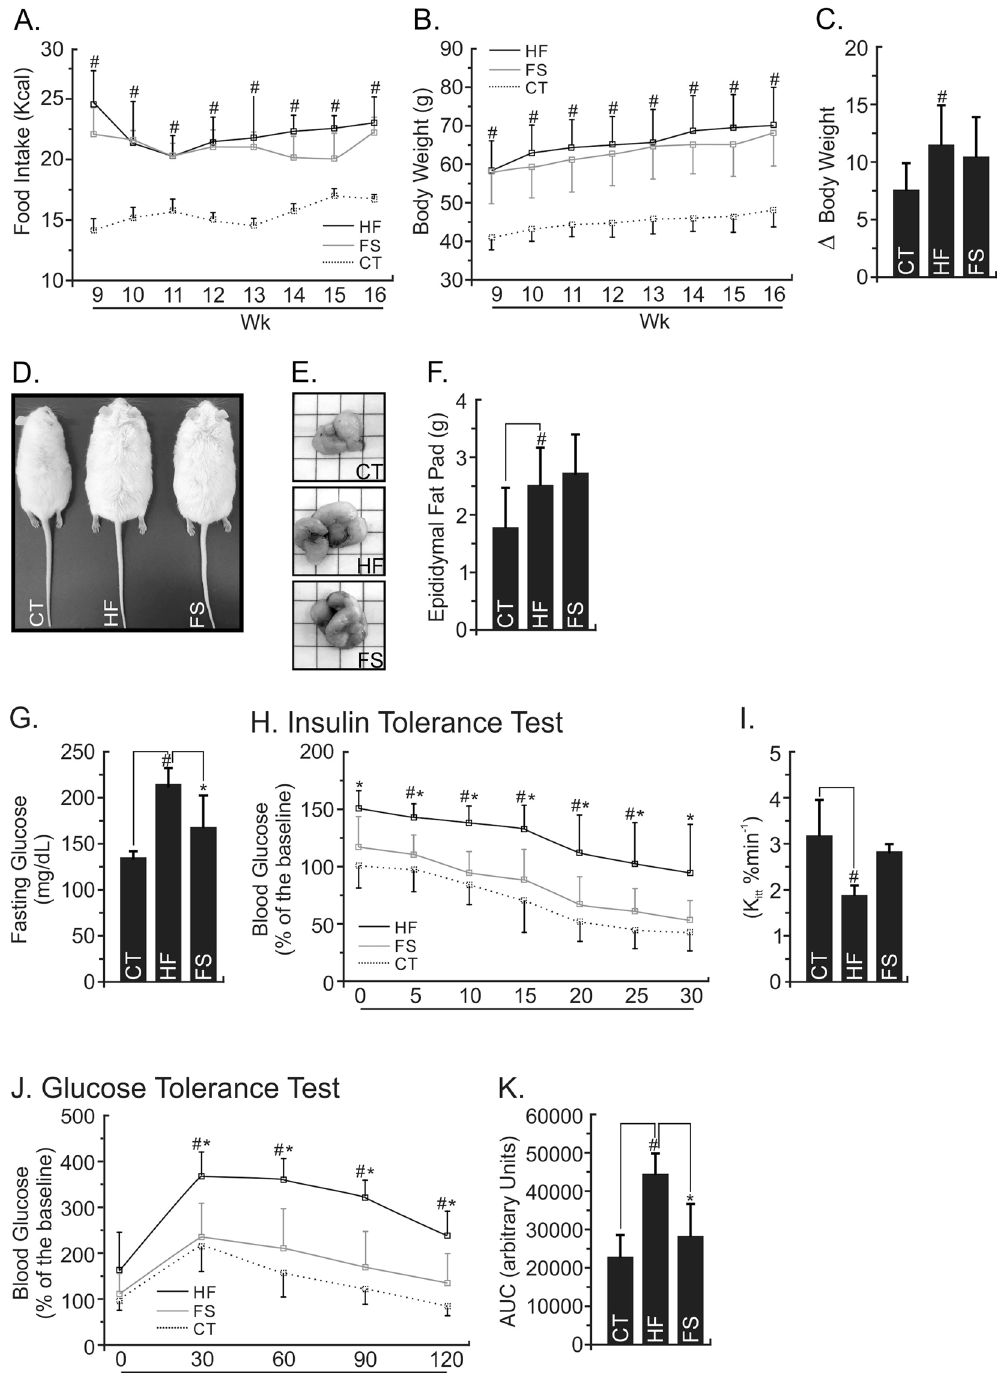
Figure 2. Effects of FS diet on the Metabolic Parameters of Obese and Diabetic Mice. ( A ) Food intake and ( B ) body mass gain for each group during the 8 last weeks under experimental diets. ( C ) The delta between the beginning (9 th wk) and last-wk (16 th wk) of body weight evaluation ( D,E ) mice illustrative and representative photographs at the end of experimental period and ( F ) average of the right flank of epididymal mice fat pad. At the end of the experimental period, the mice were submitted to ( G ) fasting glucose analysis, ( H ) insulin tolerance test (ITT) and ( I ) constant of glucose decay; ( J ) glucose tolerance test (GTT) and its ( K ) area under the curve. In all experiments, n = 5; # P < 0.05 vs. CT. * P < 0.05 vs. HF (Bonferroni’s